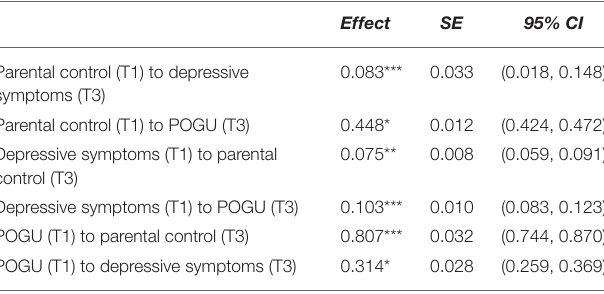
TABLE 6 | Indirect effects of parental control, depressive symptoms, and POGU.